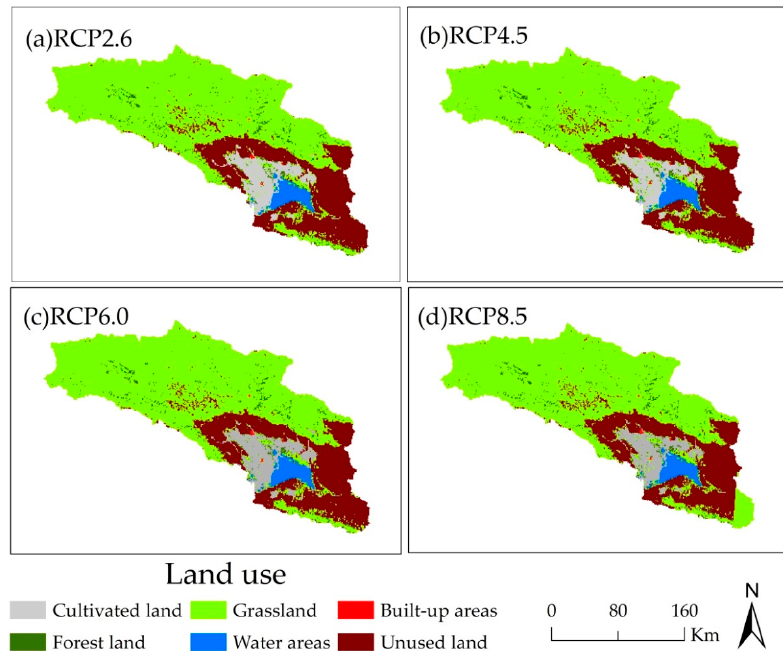
Figure 2. The distribution of land use of Bosten Lake basin in 2050 for RCP scenarios.